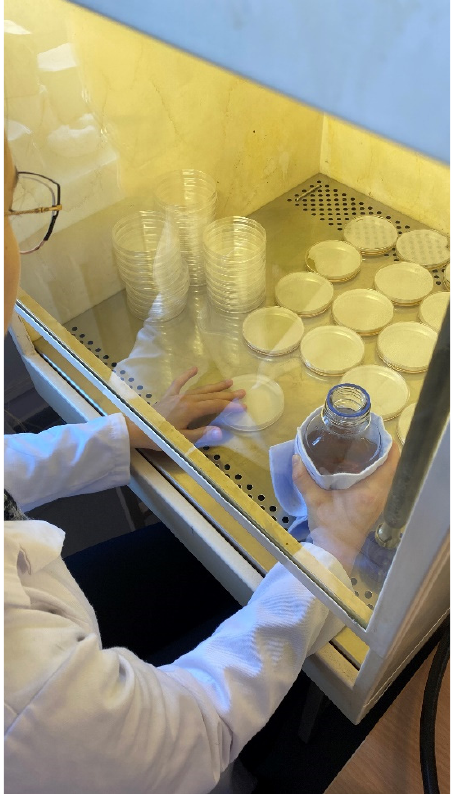
Figure 3. PDA medium in Petri